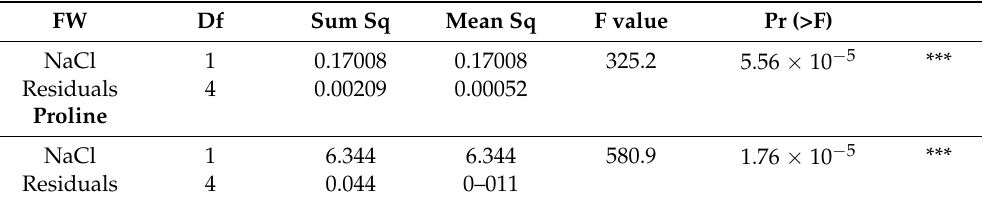
Table 2. One-way ANOVA of root FW and proline concentration after 3 weeks of culture at 0 and 60 mM NaCl. (***) Indicates significant differences ( p < 60 mM NaCl. (***) Indicates significant differences ( p < 0.001).